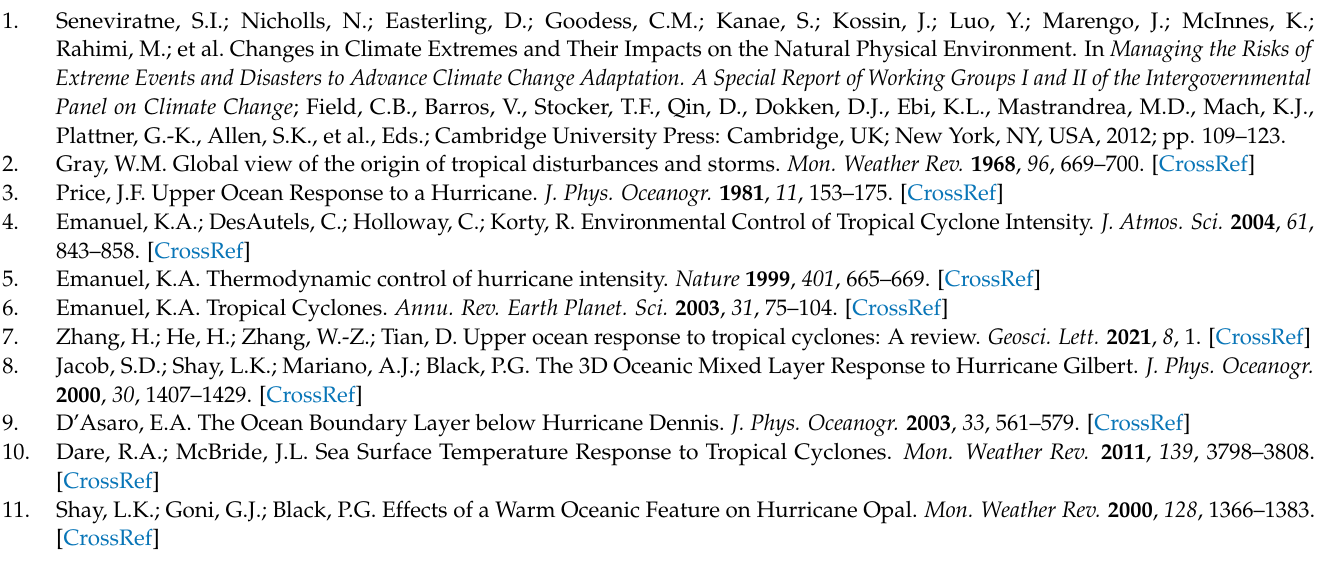
Figure S4: sea surface heights for TC Ida in the Gulf of Mexico on the 24 and 29 August